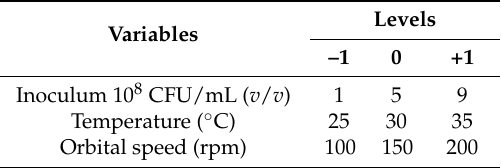
Table 1. The levels of the variables that were studied in the 2 3 full factorial design for bioemulsifier production by Bacillus subtilis UCP